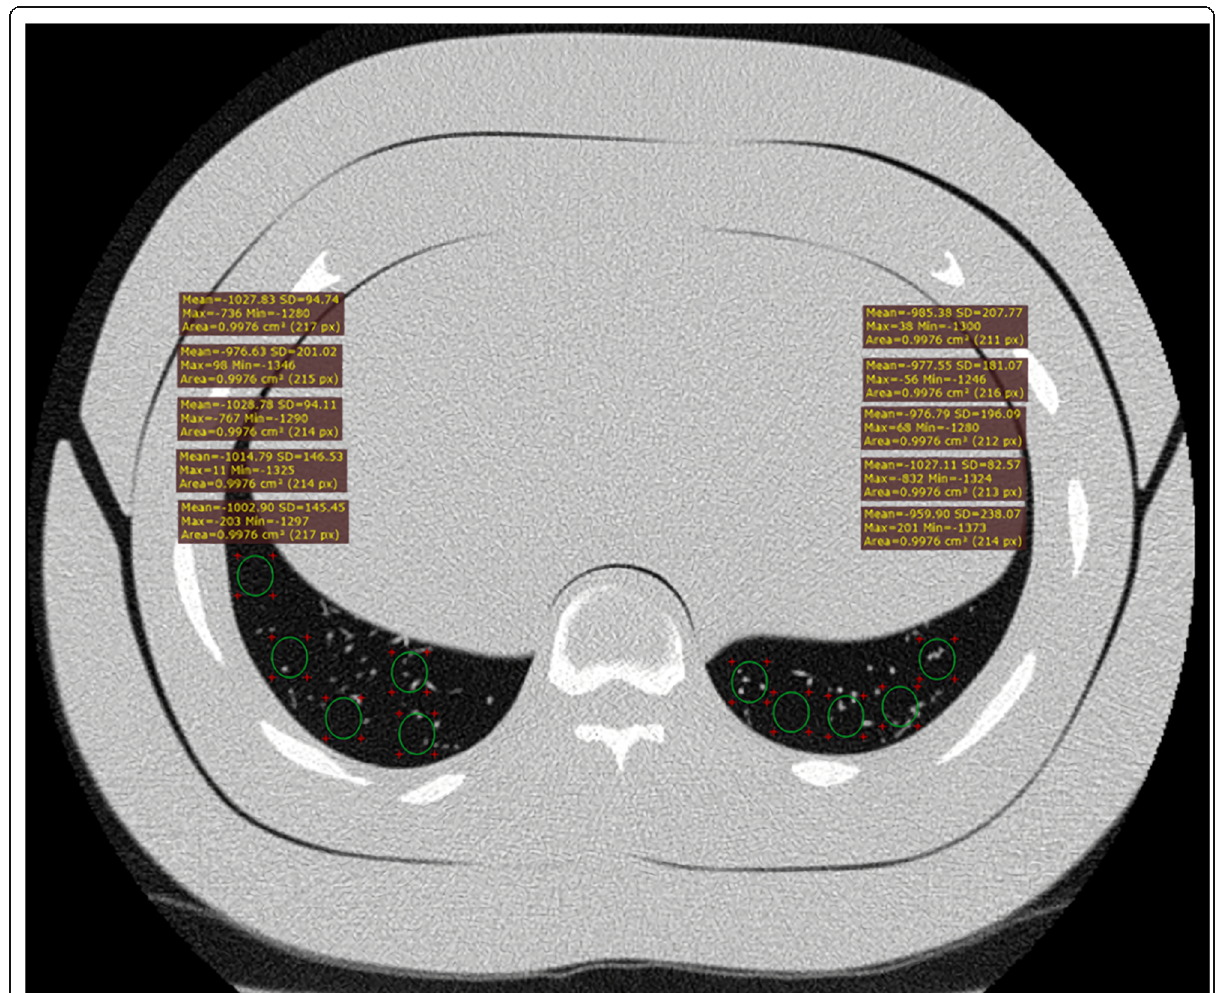
Fig. 1 The anthropomorphic phantom РН -1 Multipurpose Chest Phantom N1 with adapter plates (an equivalent to a male patient with body mass index 29). Axial slice. Standard deviation in basal regions at Th11 – 12 at 1.0-mm thickness: five measurements per lung. FC51 kernel (sharp kernel, lungs). Used software: RadiAnt DICOM Viewer